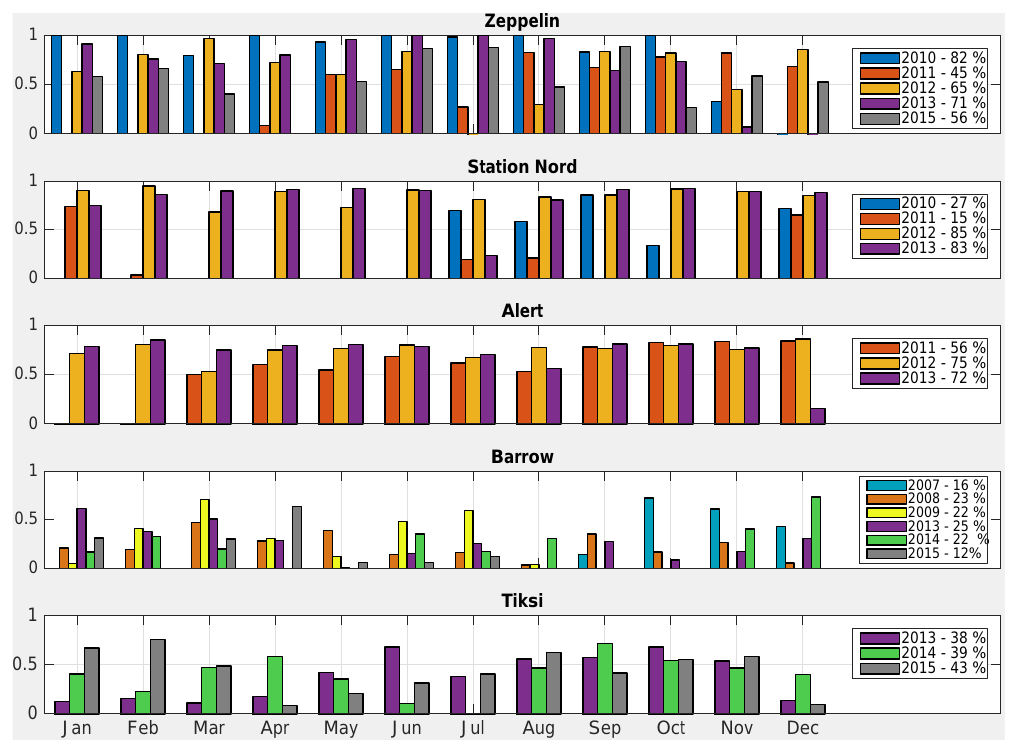
Figure 2. Data availability. The bars specify the fraction of the time within each month with available aerosol data after filtering (see Sect. 2.2). The colours of the bars represent different years, as shown in the legend, and the percentages therein indicate the yearly total data